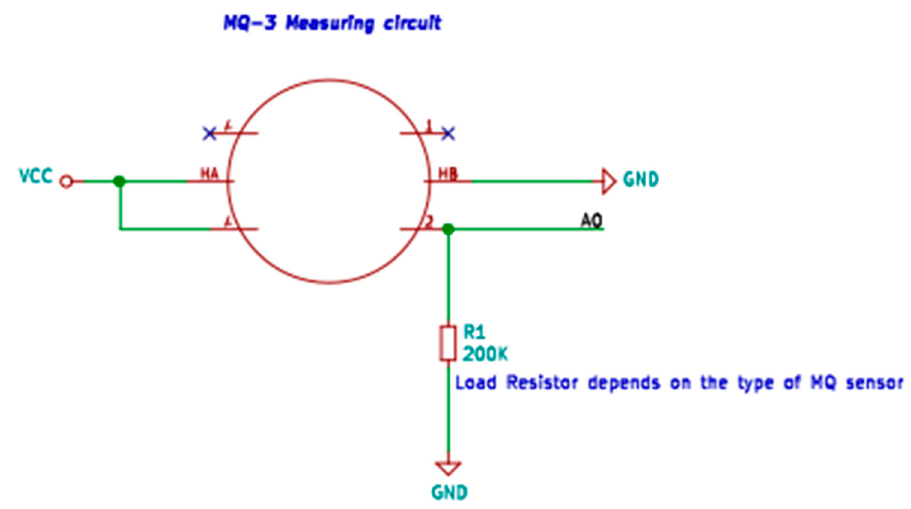
Figure 3. Single sensor circuit diagram.